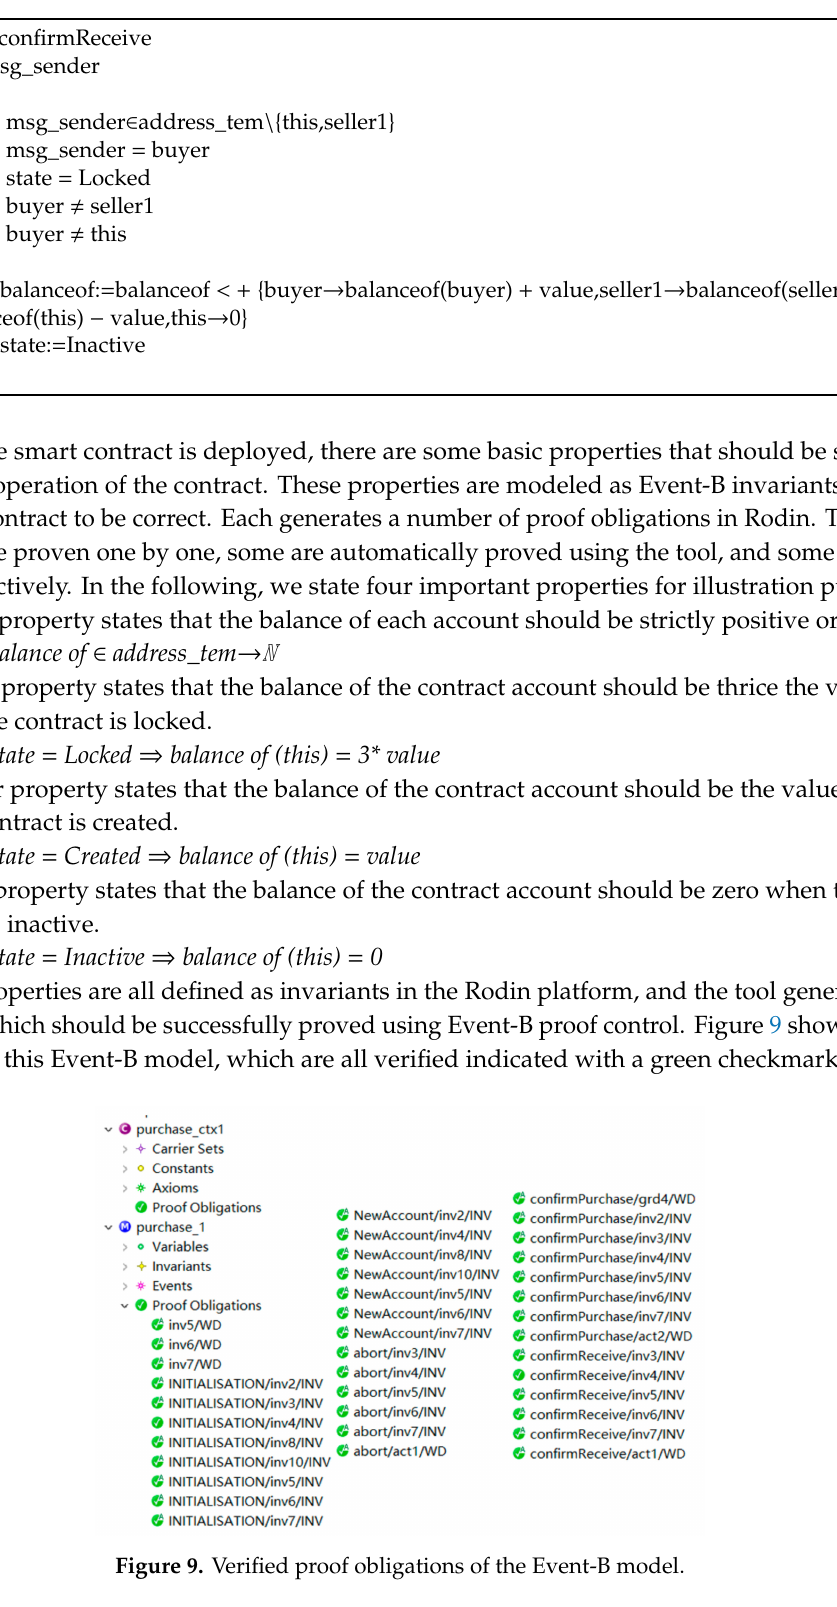
Table 4. Event “confirmReceive” of the Event-B model.